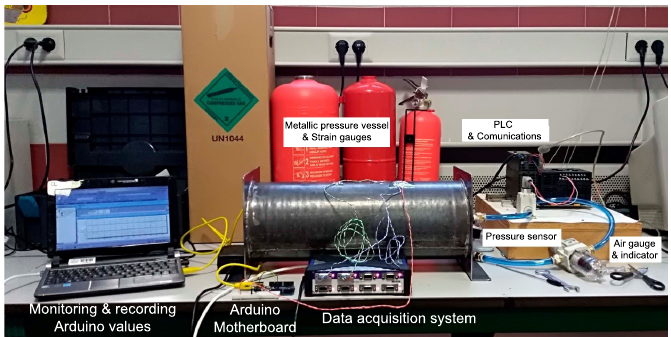
Figure 8. Laboratory validation of pressure measurement